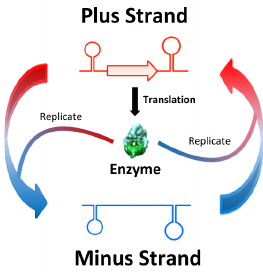
Figure 1: Molecular packet